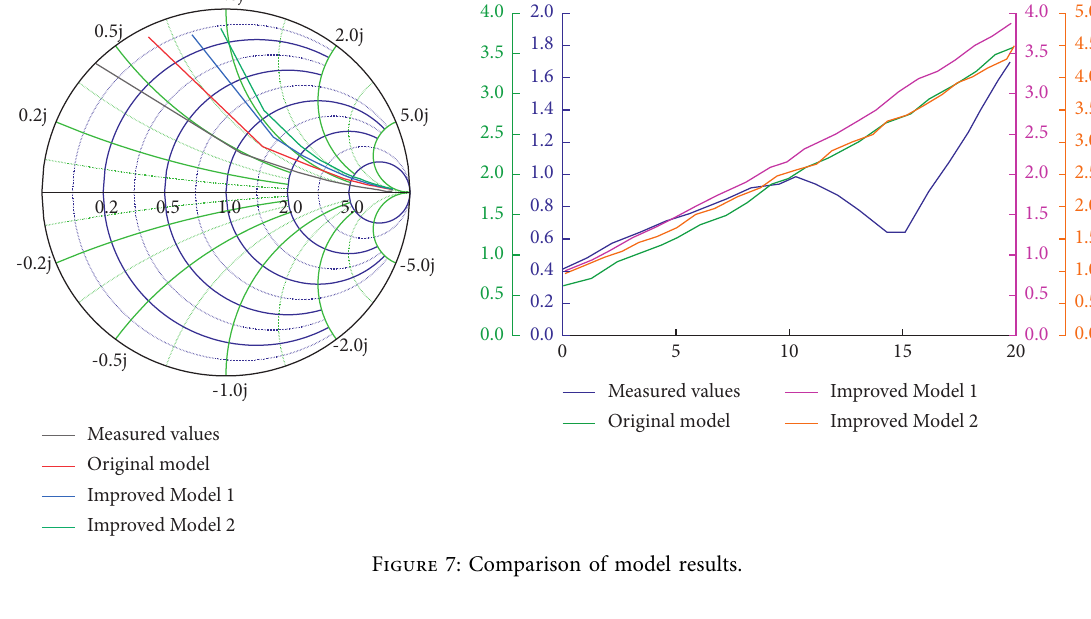
Figure 7: Comparison of model results.